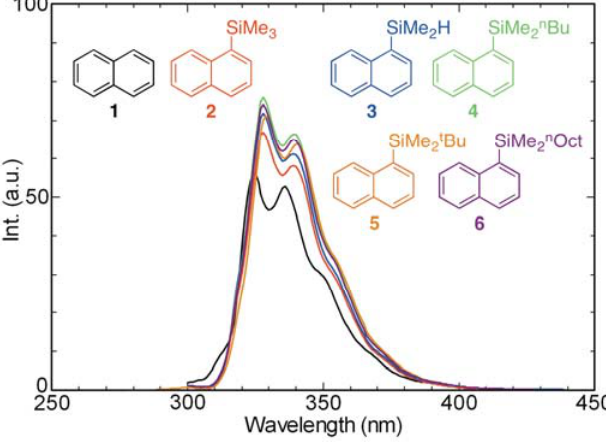
Figure 3. Fluorescence spectra of 1–6 in cyclohexane (aerated, ca. 10 − 4 M).